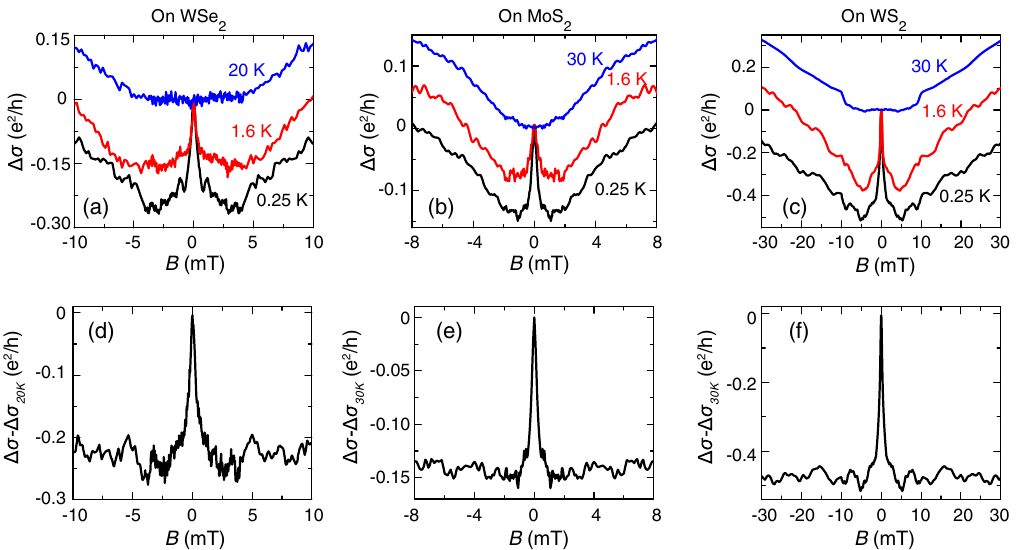
FIG. 2. Negative magnetoconductivity due to WAL in monolayer graphene on TMD substrates. (a – c) Ensemble-averaged magnetoconductivity measured on monolayer graphene on WSe 2 , MoS 2 , and WS 2 , for T ¼ 250 mK (black curve), T ¼ 1 . 6 K (red curves), and T ¼ 20 or 30 K (blue curves), with the Fermi level gate-tuned to be in the graphene valence band. The data are measured on the same devices whose V -dependent transport curves are shown in Figs. 1(d) – 1(f). The characteristic peak due to WAL g around B ¼ 0 T is clearly visible at low temperatures and disappears at higher temperatures. (d – f) Quantum corrections to magnetoconductivity of monolayer graphene on WSe 2 , MoS 2 , and WS 2 , obtained by subtracting the classical contribution (corresponding to the magnetoconductivity measured at T ¼ 20 or 30 K) from the magnetoconductivity measured at T ¼ 250 mK. Note that up to the highest magnetic field investigated, no signatures of weak localization are